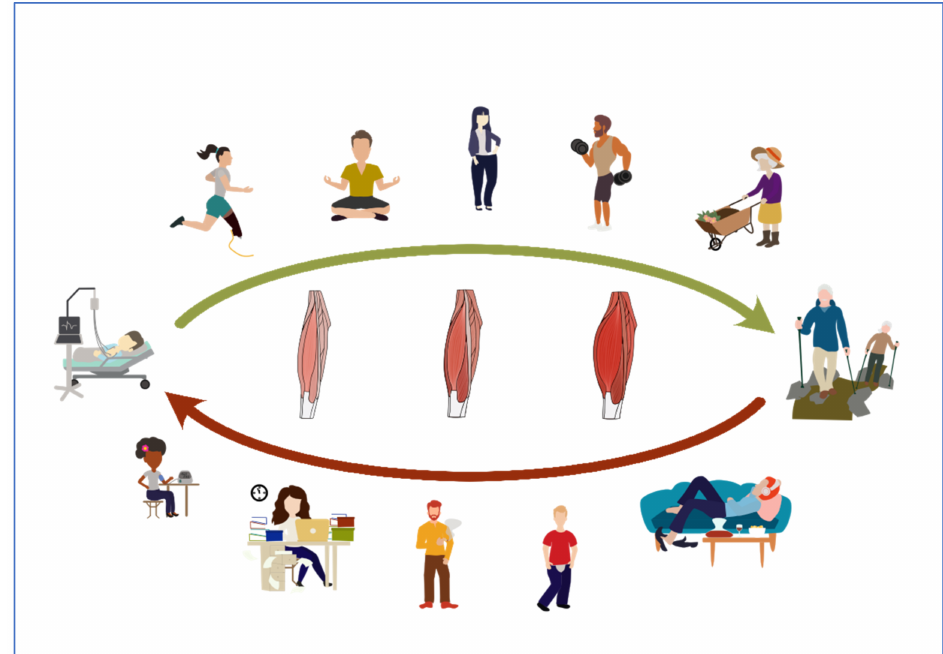
Figure 3. Potential factors that influence the myokine production. Not only sports, but also body weight management, stress reduction, nutrition, daily movement, and other lifestyle factors could enhance the myokine production. Vice versa, an unhealthy lifestyle could lead to loss of muscle mass and an impaired myokine